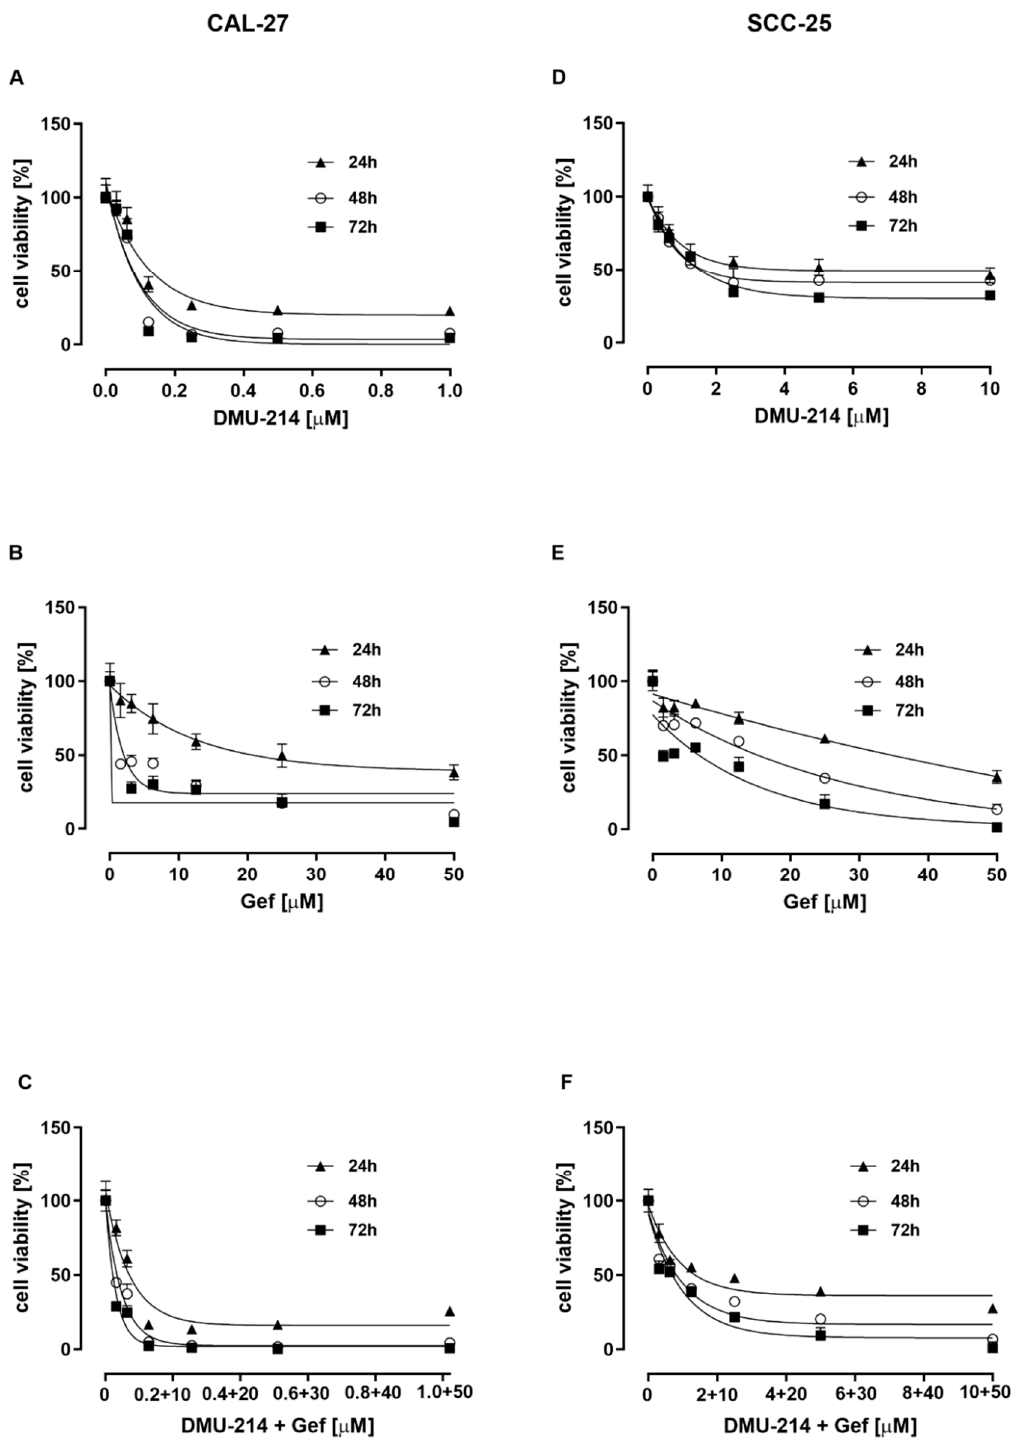
Figure 1. The cytotoxic activity of DMU-214, Gef, and the combination of DMU-214 and Gef in CAL-27 and SCC-25 cell lines. The viability of CAL-27 cells was determined after 24, 48, and 72 h incubation with DMU-214 (0–1 µ M) ( A ), Gef (0–50 µ M) ( B ), and the mixture of DMU-214 (0–1 µ M) and Gef (0–50 µ M) ( C ). The viability of the SCC-25 cell line was assessed following 24, 48, and 72 h incubation with DMU-214 (0–10 µ M) ( D ), Gef (0–50 µ M) ( E ), and the mixture of DMU-214 (0–10 µ M) and Gef (0–50 µ M) ( F ). Results of three independent replicates are presented as mean ± SD.